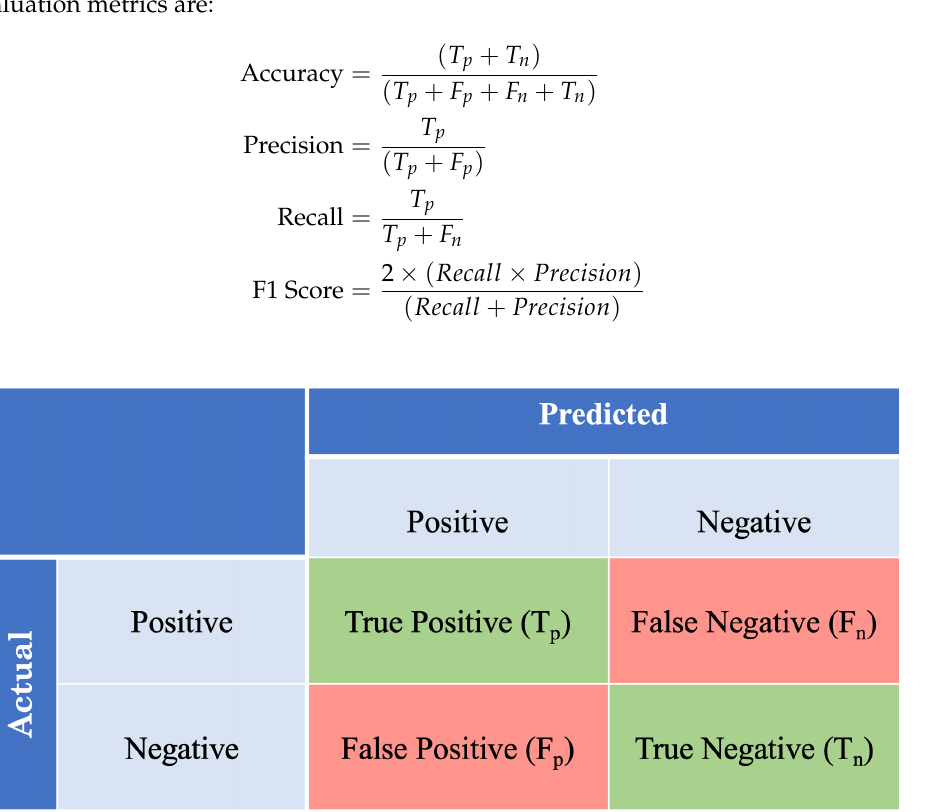
Figure 6. Confusion matrix for the evaluation